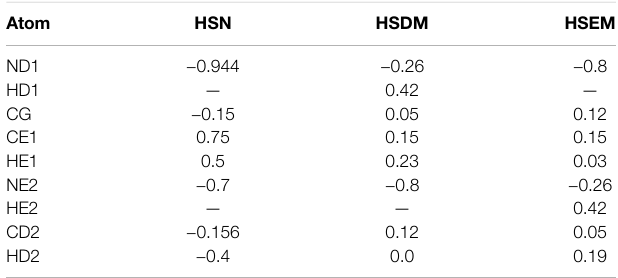
TABLE 2 | Partial charges for reparametrized histidines in the CHARMM36m force fi eld.